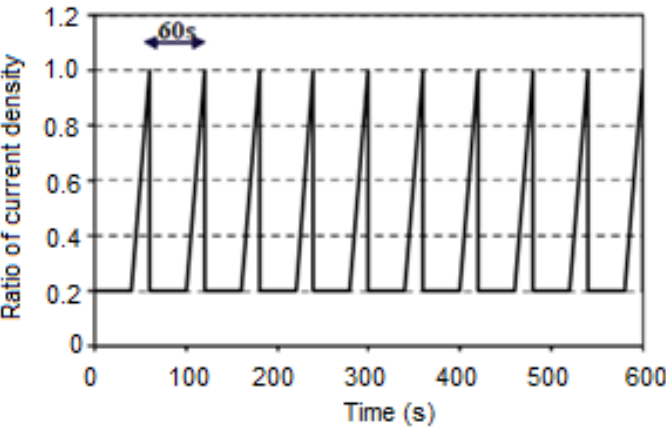
Figure 5. The dynamic test profile proposed by FCTESTNET [133] (Reproduced with permission from Ira Bloom et al. [133], ESC Transactions; published by The Electrochemical Society, 2013).